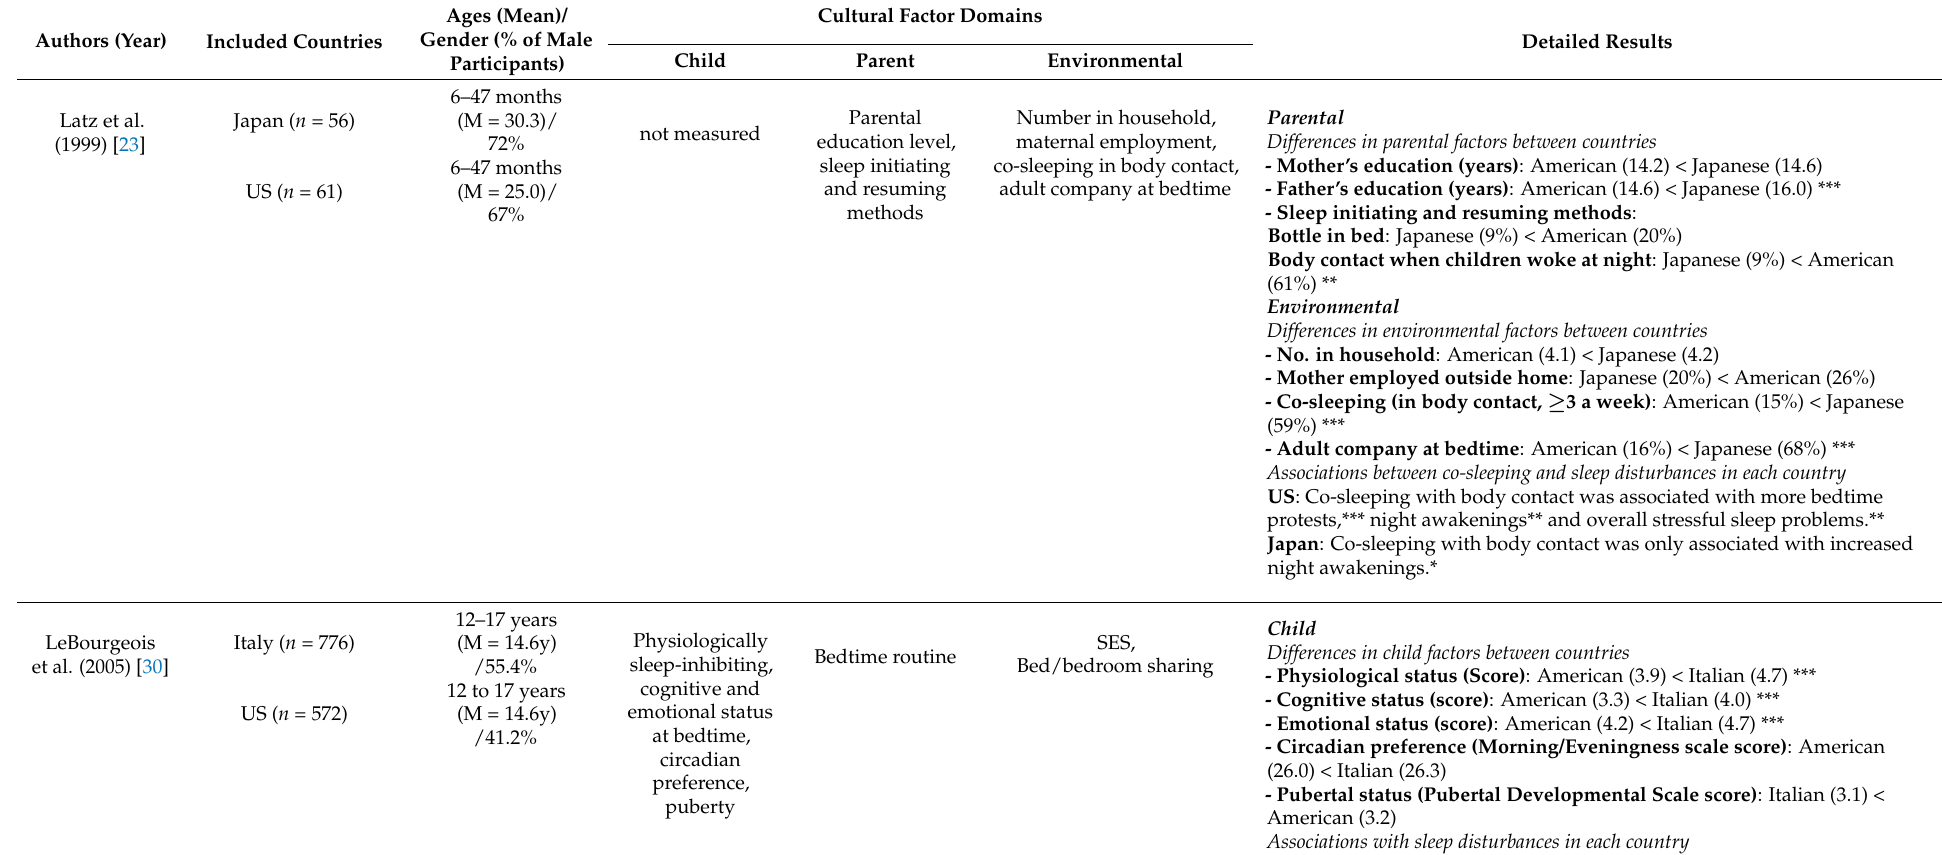
Table A2. Cultural factors examined with sleep duration or sleep